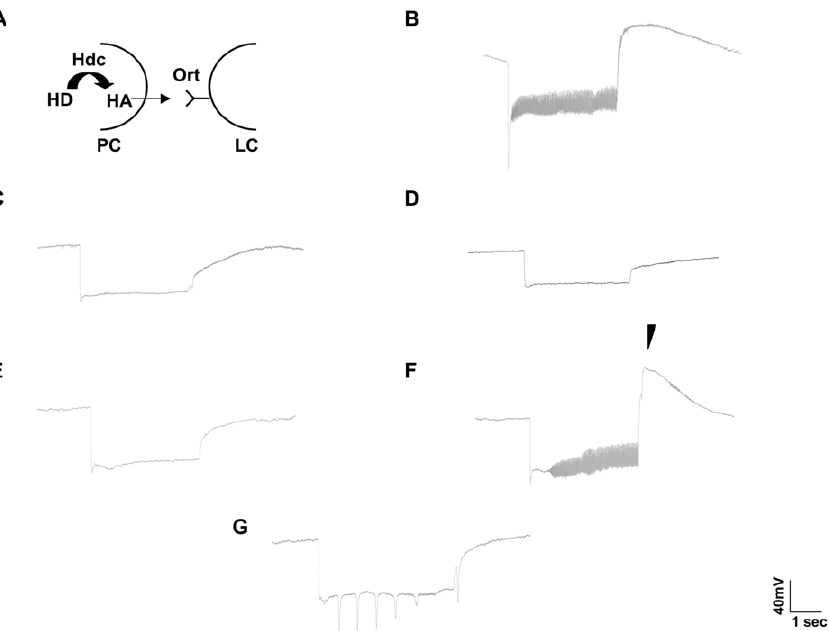
Figure 2. Histamine Synthesis, But Not Postsynaptic Histamine Signaling, Is Required for the ine Mutant ERG Phenotype (A) Simplistic diagram showing the synthesis and activity of histamine in the Drosophila eye. HD, histidine; Hdc, histidine decarboxylase; HA, histamine; Ort, histamine-gated chloride channel; PC, photoreceptor cell; LC, postsynaptic laminar cell. Histamine is generated by histidine decarboxylase from histidine in the photoreceptor cell. It is then released and acts upon a histamine-gated chloride channel on the postsynaptic laminar cell to trigger downstream signaling in the eye. ERG recordings from (B) ine 2 , (C) Hdc P218 , (D) ine 2 Hdc P218 , (E) ort 5 , and (F) ine 2 ;ort 5 flies. Note that Hdc P218 rescues the ine 2 -oscillations, but that ort mutations do not. (G) ERG recordings from 76% of ort 5 flies exhibit strong depolarization spikes. Filled arrowheads indicate a hyper-repolarization response. All flies possessed white eyes due to the presence of the w 1118